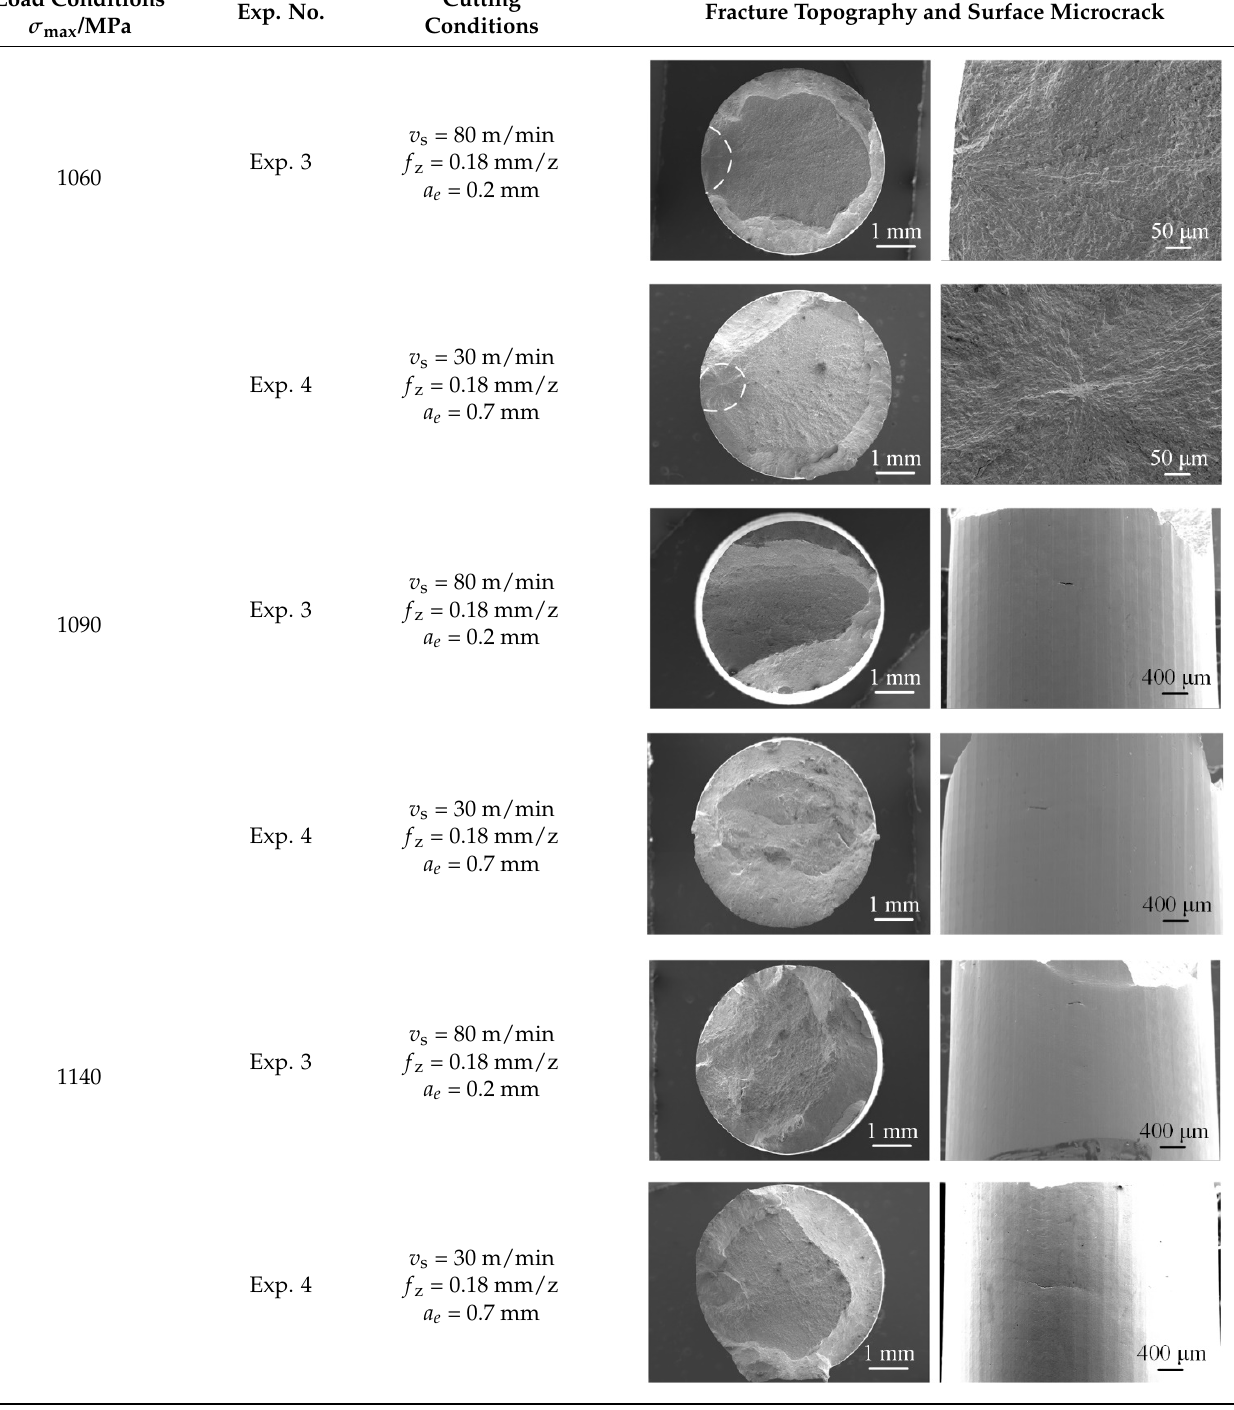
Table 9. Fracture topography and microscopic surface of TC17 specimens.